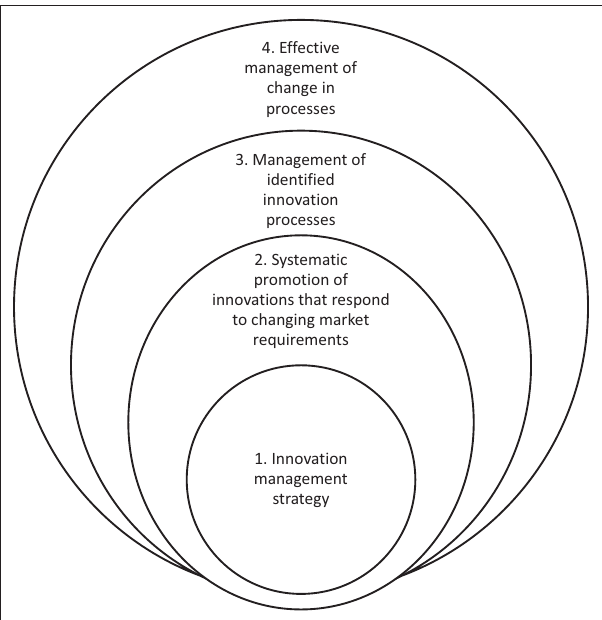
FIGURE 1: Processes of innovation